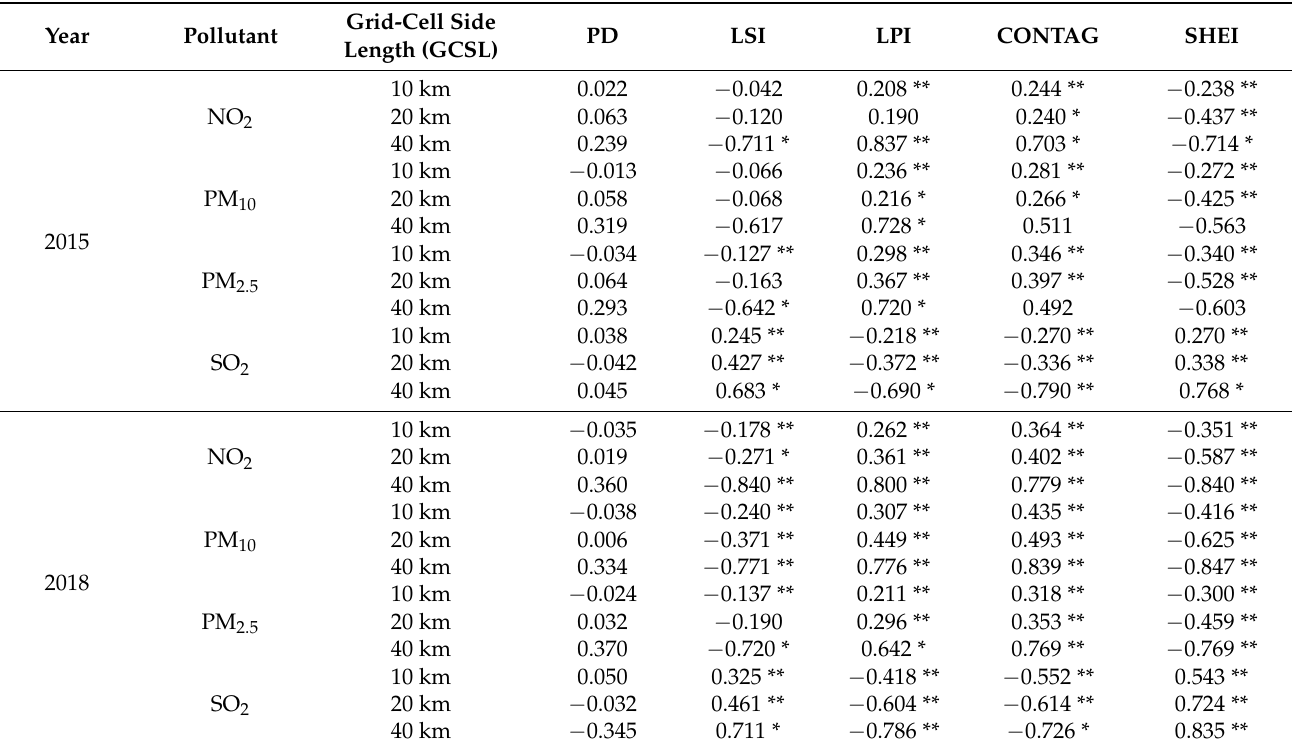
Table 4. Correlations between the concentrations of the four pollutants and the landscape-level landscape pattern metrics at different